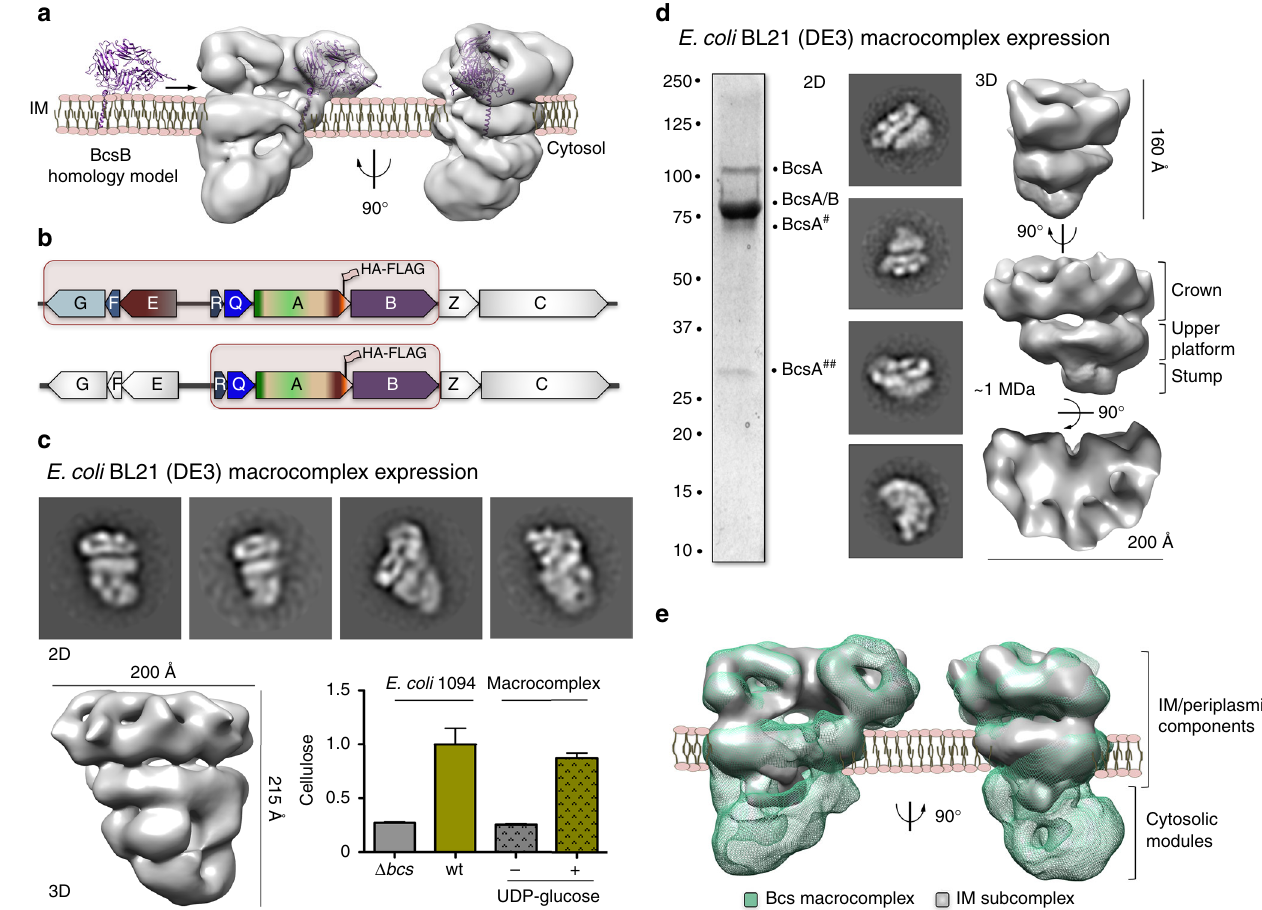
Fig. 3 Map interpretation and electron microscopy studies of an inner membrane (IM) subcomplex. a Representative fi tting of a BcsB homology model in a crown repeat volume and proposed orientation of the Bcs macrocomplex relative to the inner membrane. b Co-expressed subunits for recombinant overexpression and Bcs complex reconstitution in BL21 (DE3) cells (macrocomplex: top; IM subcomplex: bottom). c Structural and functional analyses of the recombinantly expressed Bcs macrocomplex. Representative 2D class averages are shown on the top (not to scale); the 3D structure reconstruction is shown on the bottom. End-point de novo cellulose synthesis by the puri fi ed complex is shown on the bottom; results are representative of two biological replicates. The data is plotted relative to cellulose detection in a wild-type E . coli 1094 cell culture, with bcs operon-deleted strain serving as negative control. d Structural analyses of the IM subcomplex. A coomassie-stained SDS-PAGE gel, 2D class averages (not to scale) and different views of the 3D structure reconstruction are shown from left to right. The corresponding molecular weight is indicated in megadaltons and the dimensions of the subcomplex are indicated by size bars. e . Fitting of the IM subcomplex into the Bcs macrocomplex volume and proposed orientation relative to the